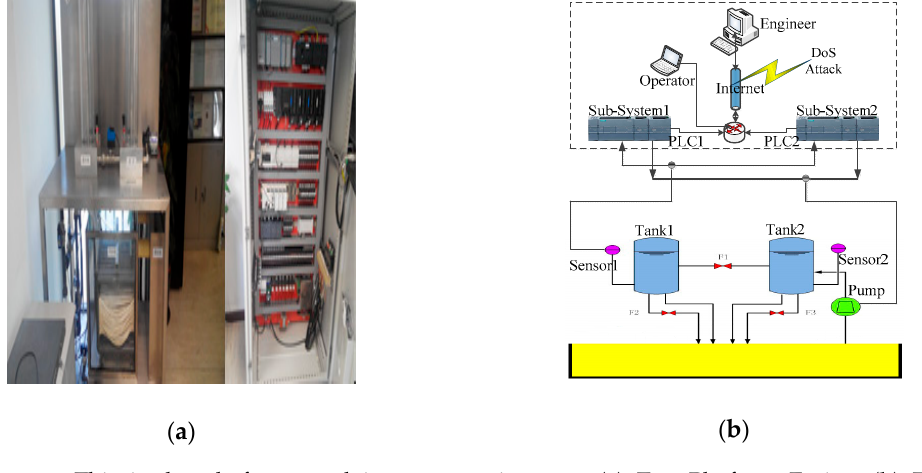
Figure 9. This is the platform used in our experiments. ( a ) Test Platform Entity; ( b ) Test Platform